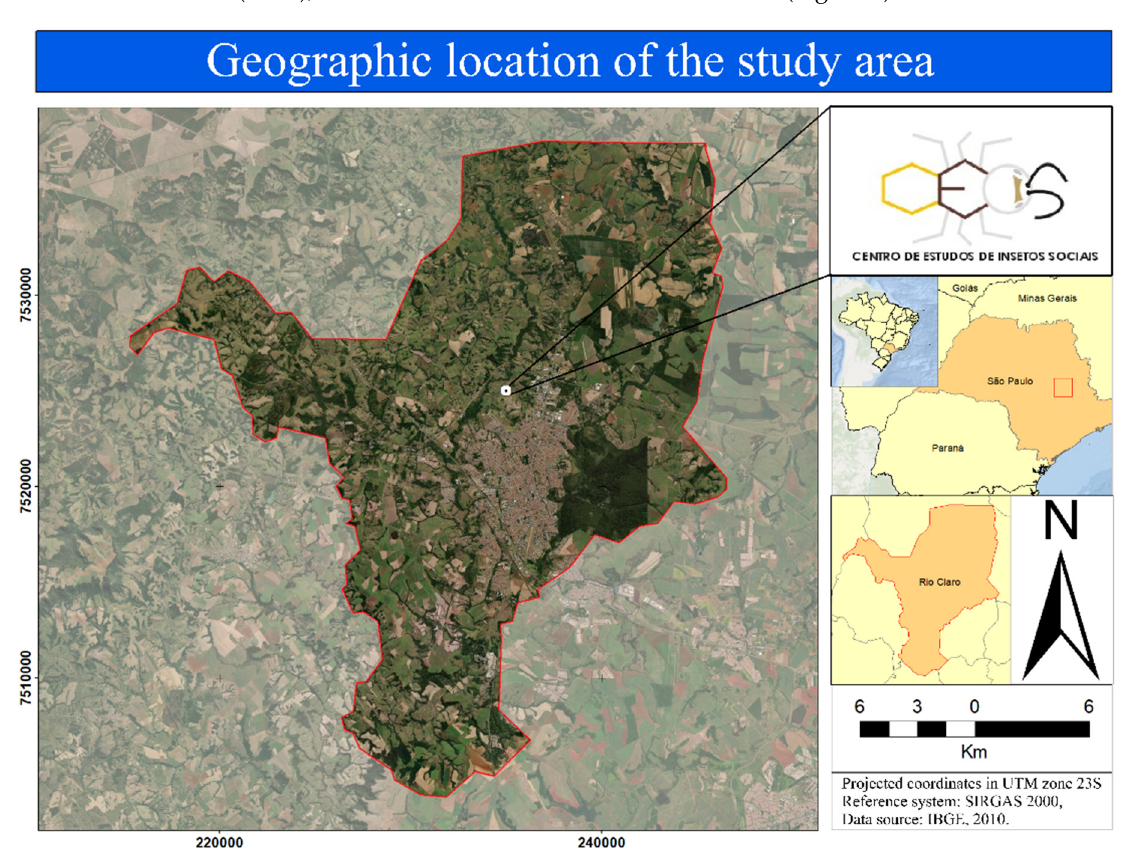
Figure 1. Location of the “Centro de Estudos de Insetos Sociais (CEIS)” in the Rio Claro municipality, where ecotoxicological studies were carried out with foragers of Africanized honey